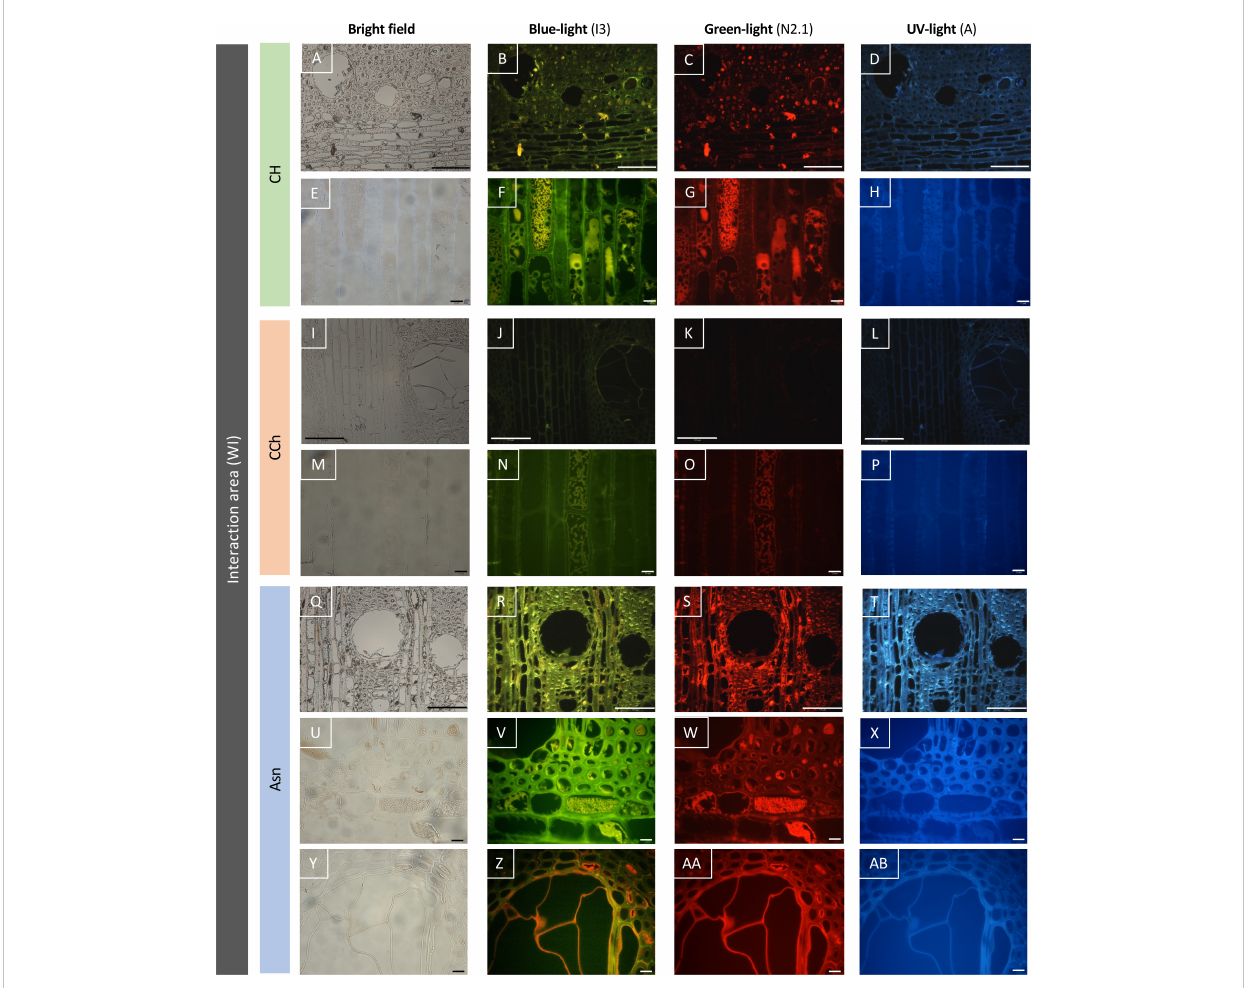
FIGURE 7 Observation of the auto fl uorescence of woody tissues sampled in the interaction area (WI), according to different types of excitations (blue, green, or UV light) revealed by epi fl uorescence microscopy. The Asn modality (R – T, V – X, Z – AB) reveals an intensity of auto fl uorescence higher than the asymptomatic control modality (CH, B – D, F – H) , and the wood of the CCh modality (with chronic symptoms, J – L, N – P ) is the least auto fl uorescent. Bar: 100 m m (A – D, I – L, Q – T) or 10 m m (E – H, M – P, U – AB)